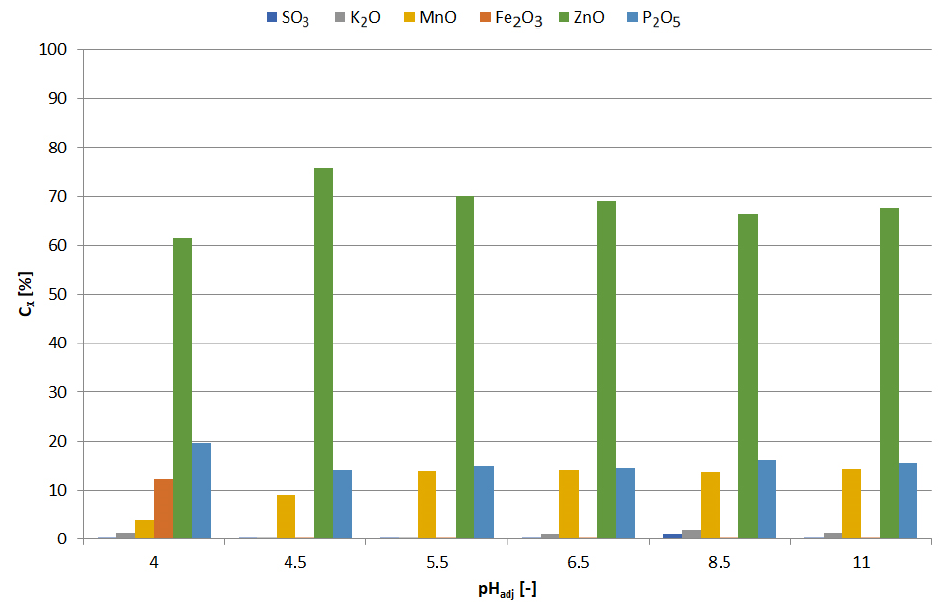
Figure 24. Effect of adjusted pH (pH adj ) on chemical composition of precipitates as a result of precipitation by using Na 3 PO 4 from selective leaching solution.